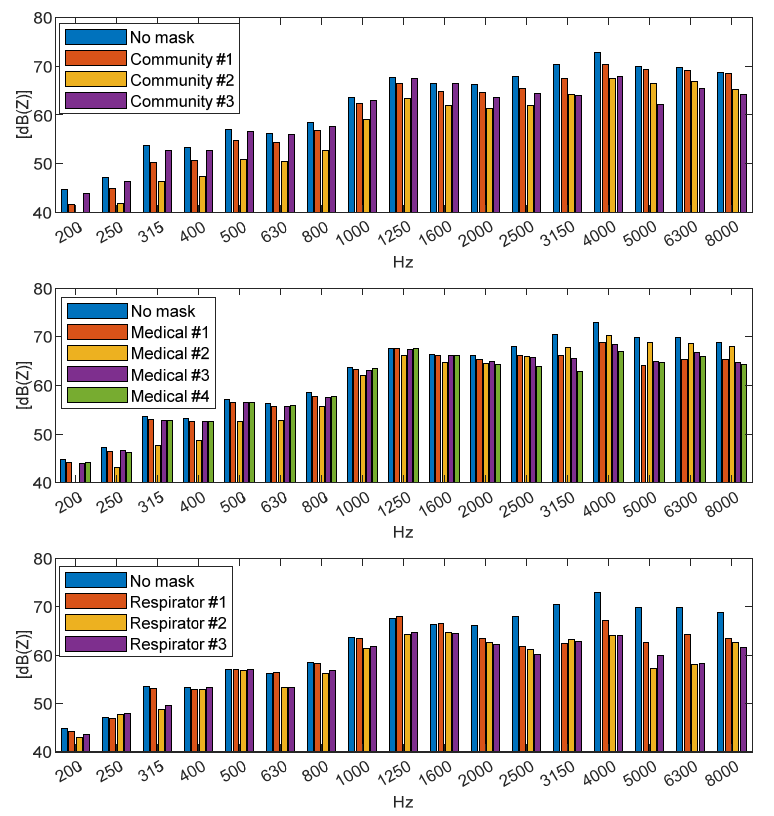
Figure 8. 1/3 octave spectrua of the acoustic pressure for the different mask types: community masks ( top ), medical ( center ), and respirator ( bottom ). The decibel reference is 20 µPa.